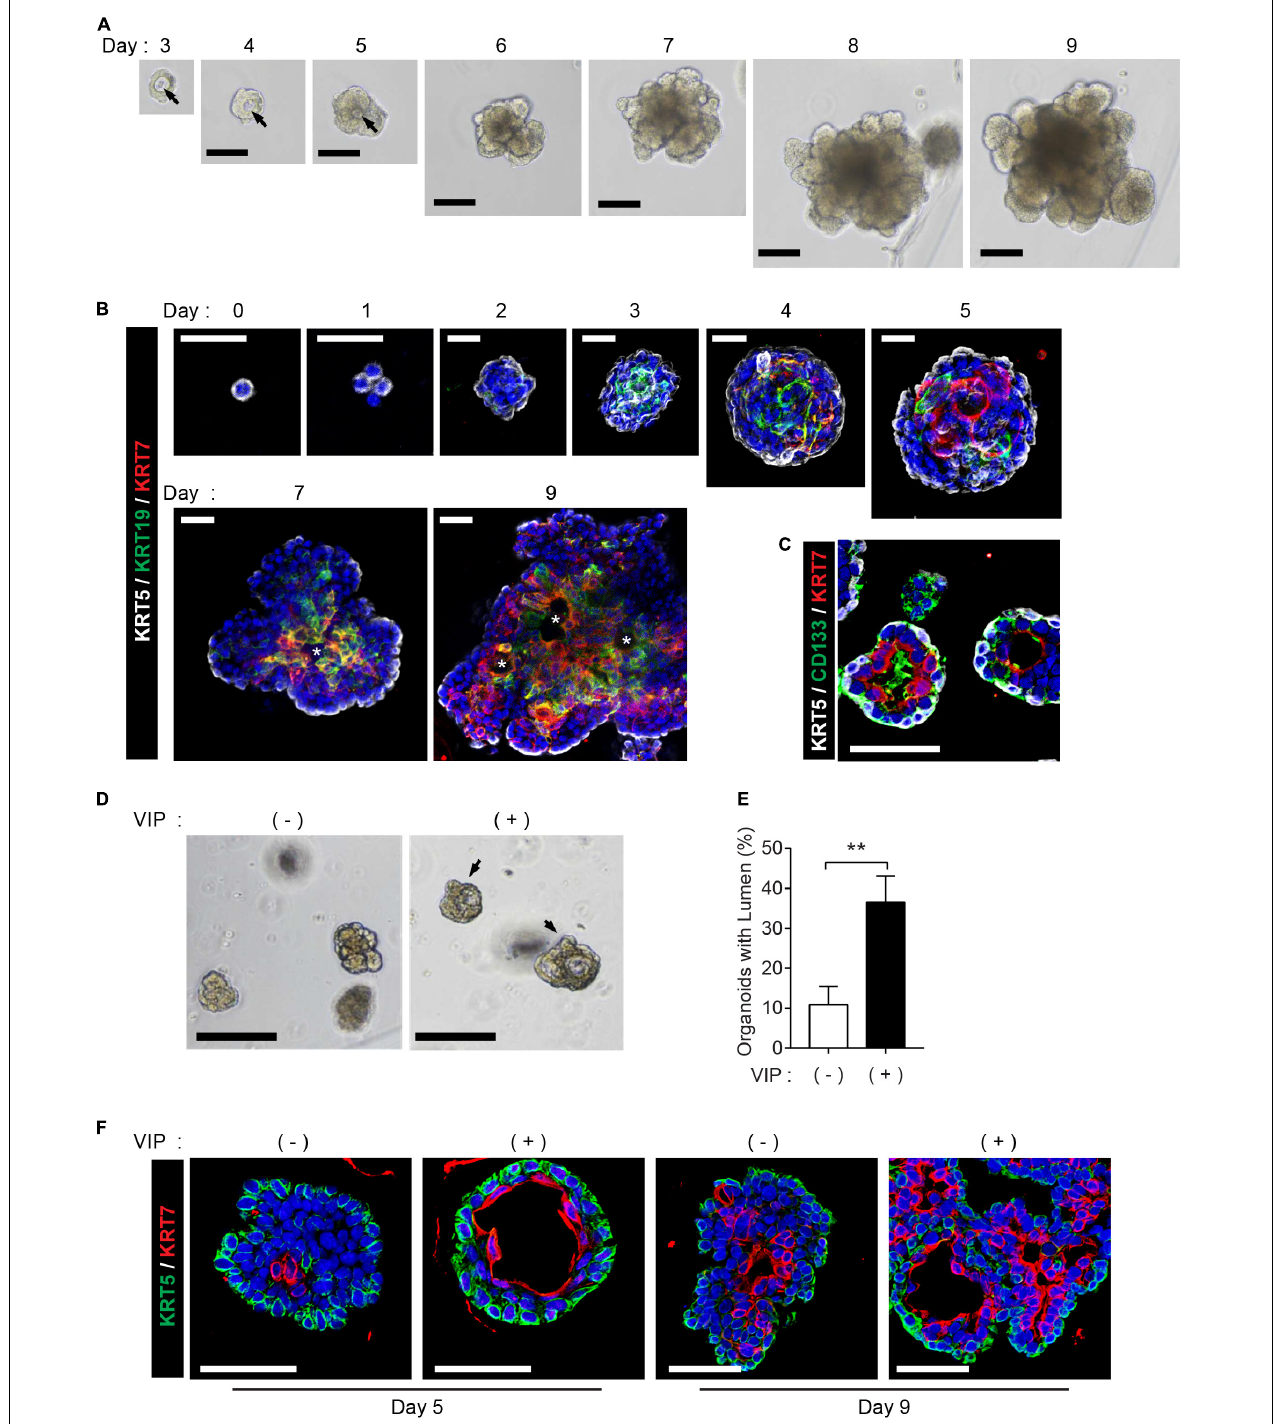
FIGURE 1 | Recapitulation of lumen formation during SMG development in a mouse SMG organoid culture. (A) Organoid growth from single cells was monitored at each time point. Black arrows indicate internal lumen formation as shown in the bright-field microscopy images. Scale bar indicates 100 µ m. (B) SMG organoids were harvested at each time point and subjected to whole-mount immunofluorescence microscopy for the evaluation of KRT5 (white), KRT19 (green), and KRT7 (red) expressions from days 0 to 9. Up to day 5, images were obtained through maximum intensity projection. From days 7 to 9, single images were obtained from z-stack. Micro-lumens were denoted with white asterisks. Scale bars indicate 20 µ m. Nuclei were counterstained with DAPI (blue). (C) KRT5 (white), CD133 (green), and KRT7 (red) expressions on day 4. Scale bars indicate 50 µ m. Nuclei were counterstained with DAPI (blue). (D) The organoids were treated with 200 nM of